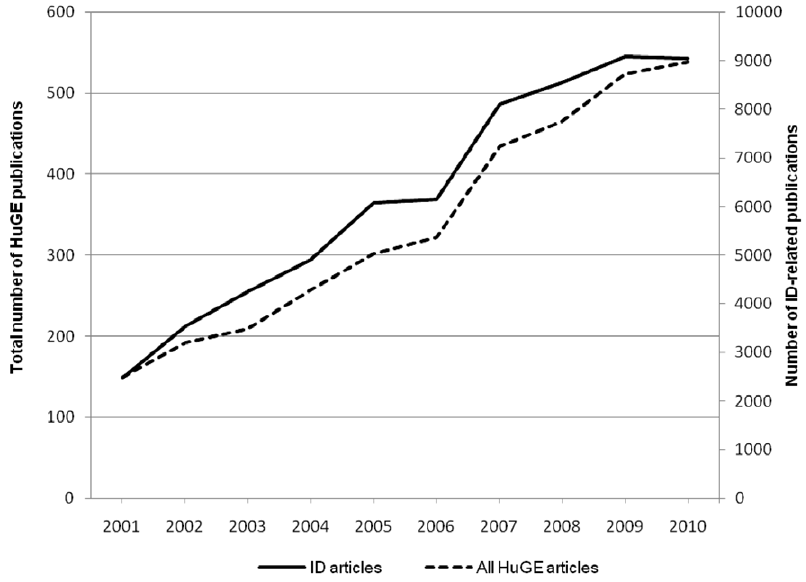
Figure 1. Trend in publication of infectious disease-related articles in human genome epidemiology, 2001–2010. doi:10.1371/journal.pone.0025431.g001 PLoS ONE |